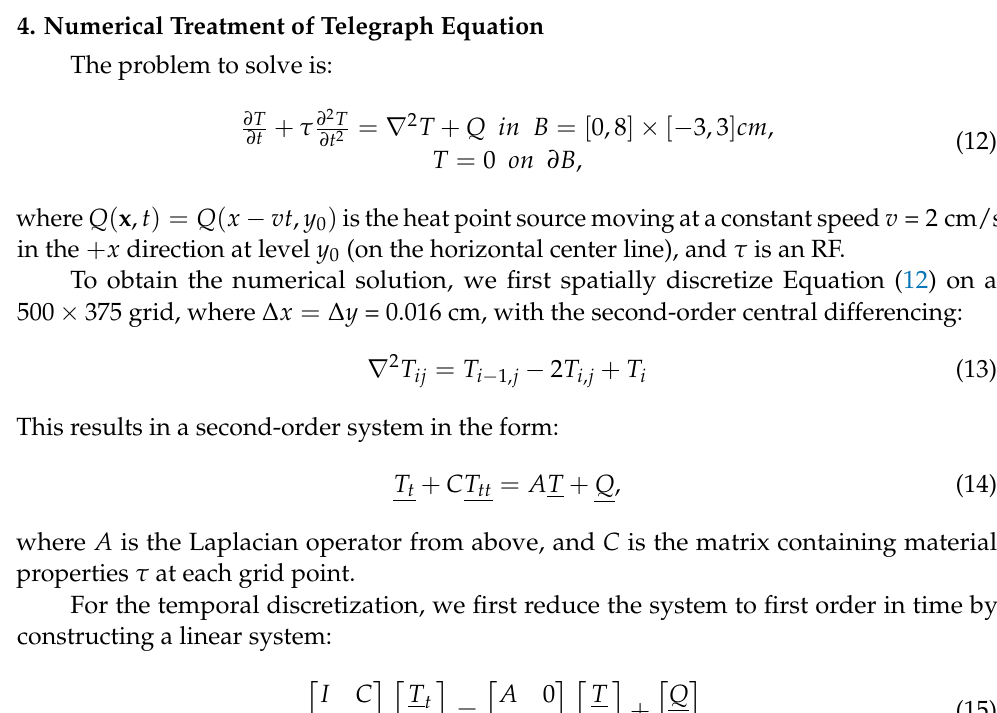
Figure 3. Realizations of Dagum random fields with columns (from left to right) at α = 0.4,0.6,0.8 and horizontal rows (from top to bottom) β =